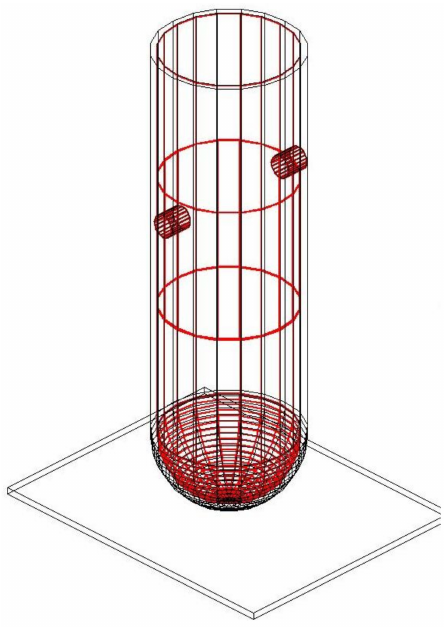
Figure 2. Illustration of the reactor pressure vessel at Kori unit 1.